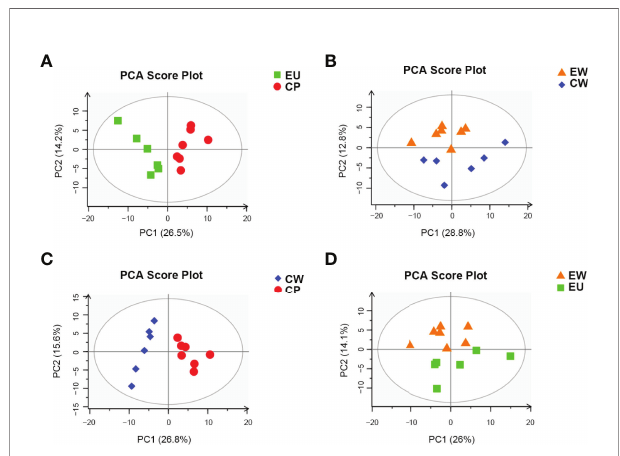
FIGURE 2 | PCA score plots based on pairwise comparisons between different groups. (A) EU vs. CP, (B) EW vs. CW, (C) CW vs. CP, and (D) EW vs. EU